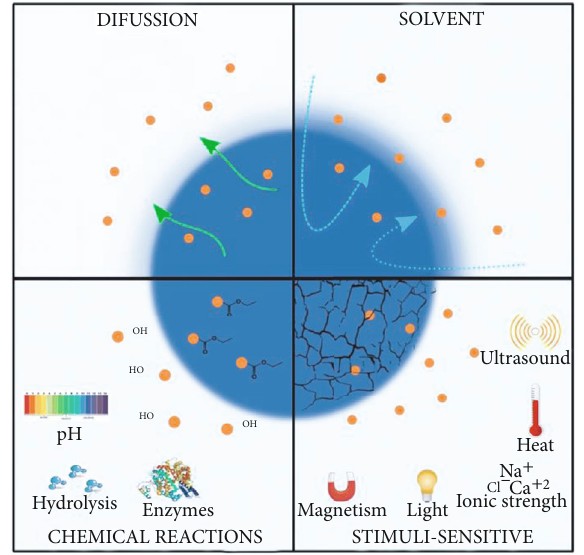
Figure 4: Mechanisms for controlled drug release using diverse types of carriers